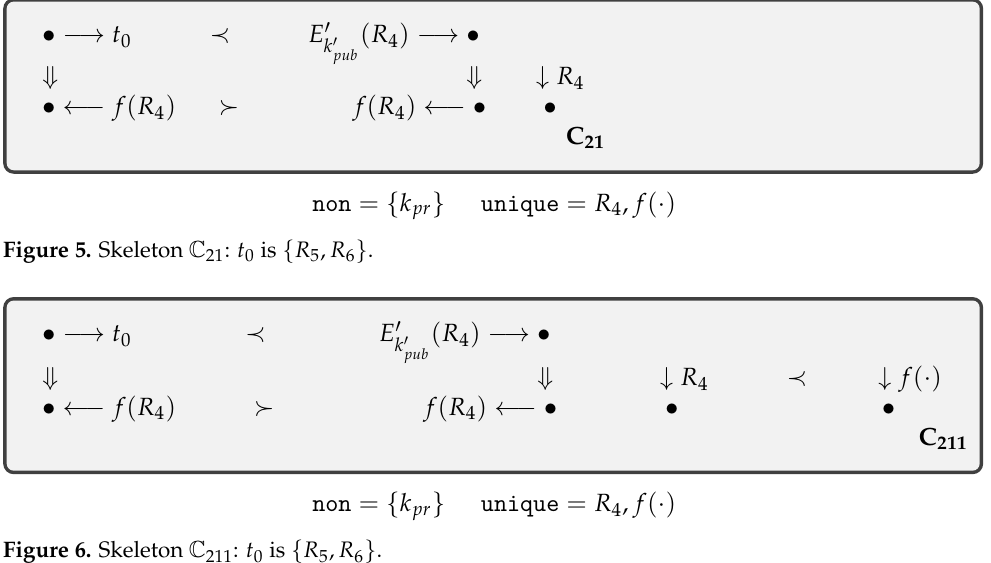
Figure 6. Skeleton C 211 : t 0 is { R 5 , R 6 }